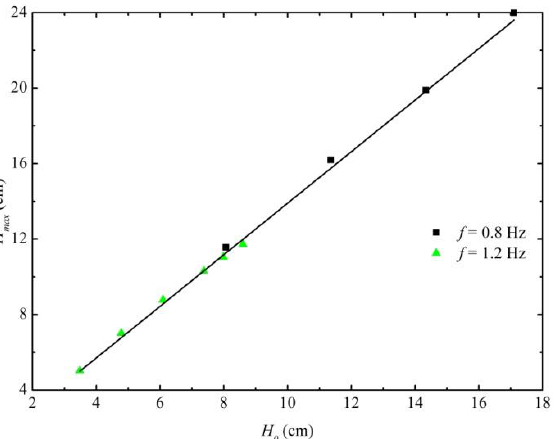
Figure 5. The maximum wave height against the initial input steepness for two different frequencies. The solid line represents a linear least-squares fit: H max = 1.37 H 0 , R 2 = 0.996.